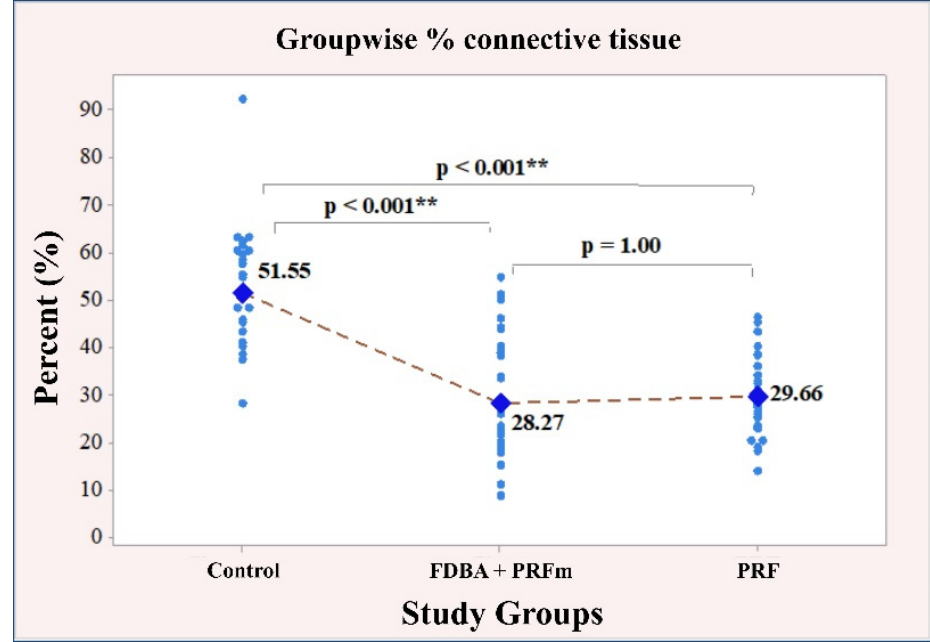
Figure 9 . Individual and mean values of % connective tissue. ** denotes significant difference between groups.